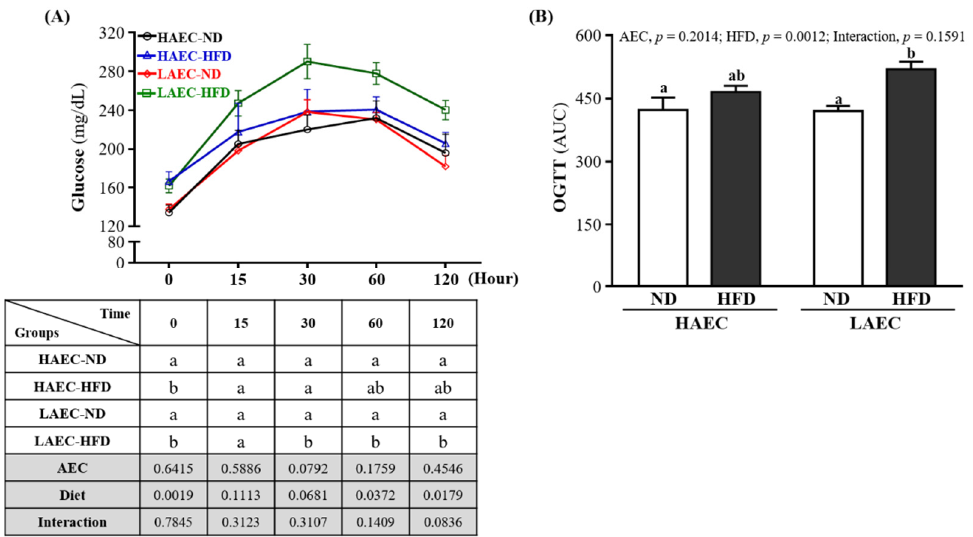
Figure 3. Effects of 12 weeks’ HFD feeding of HAEC or LAEC postpartum mice on: ( A ) oral glucose tolerance test (OGTT) curve; and ( B ) area under the curve. Data are mean ± SEM for n = 8 mice per group. Columns with different superscript letters (a, b) are significantly different between groups at p < 0.05.